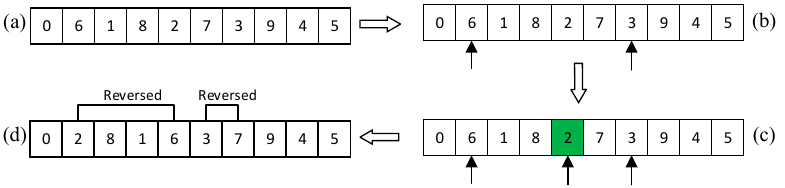
Figure 6. Mutation operation: ( a ) randomly extract an individual from the population with a preset mutation probability, ( b ) Randomly obtain the start and end position indices for the mutation opera- tion, ( c ) calculate the middle position index between the start and end position indices, ( d ) Reverse the order of the numbers in two